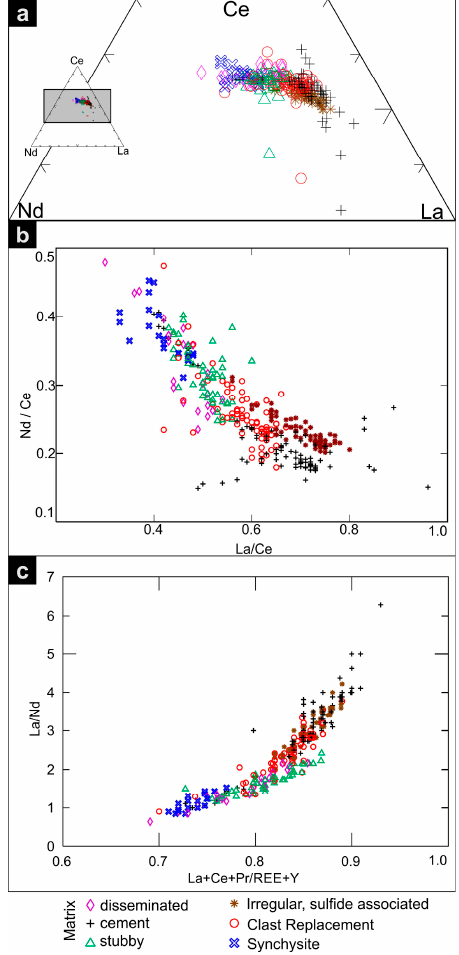
Figure 8. REE compositions of bastnäsite and synchysite (EMPA data, a.p.f.u.): ( a ) Ternary Nd-Ce-La plot showing progression of bastnäsite sub-groups from Ce- and Nd- to La-enriched; ( b ) La/Ce vs. Nd/Ce showing clustering of bastnäsite textural groups and separation of irregular and fine-grained cement bastnäsite; ( c ) Relative LREE ratios (after [35]) showing a continuous curve through synchysite, clast replacement, irregular, and fine-grained matrix bastnäsite, and stubby bastnäsite plotting astray from the curve.